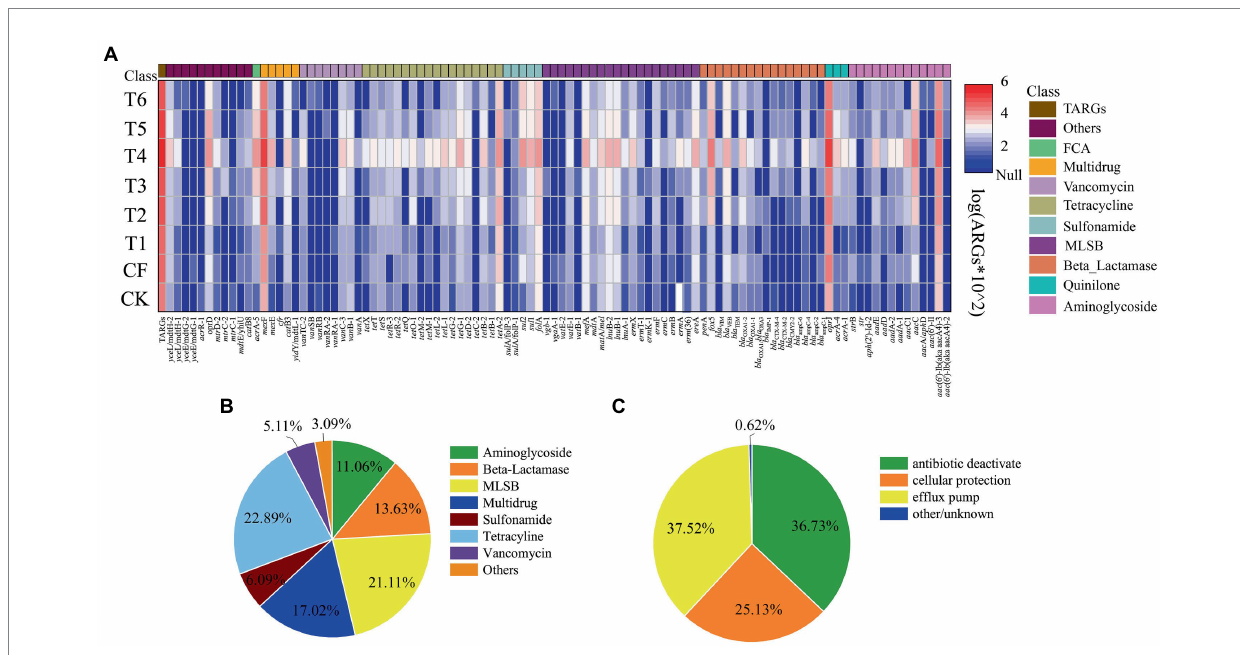
FIGURE 1 The content of detected ARGs under different fertilization modes in high-throughput sequencing technology (A) the abundance of all genes detected, (B) proportion of different subtypes of ARGs, (C) proportion of antibiotic resistance mechanisms. CK, no fertilization; CF, conventional fertilization; T1, conventional fertilization was reduced by 20%; T2, organic fertilizer replaced T1 (in terms of nitrogen); T3, organic fertilizer replaced T1 and urea supplemented nitrogen (in terms of phosphorus); T4, considering the mineralization rate of organic fertilizer is 25%, organic fertilizer replaced T1 (in terms of nitrogen); T5, considering the mineralization rate of organic fertilizer is 25%, organic fertilizer replaces T1, and urea supplemented nitrogen (in terms of phosphorus); T6, slow release